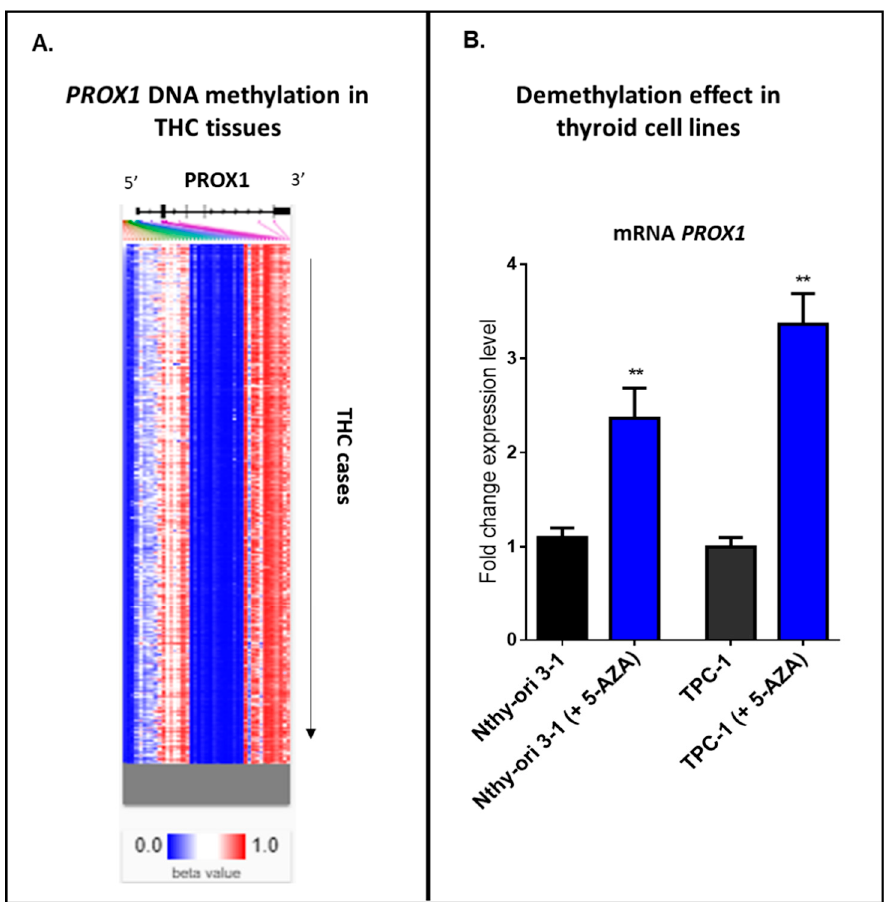
Figure 4. Methylation in THC cases. A. Hierarchical clustering of THC tissues; blue indicates a low level or no methylation for PROX1; red indicates a high methylation level. The methylation analysis was studied using https://xenabrowser.net/heatmap/. B. Treatment of the immortalized normal thyroid cells (Nthy ori-3-1) and PTC-derived cell line (TPC-1) with 5 μ M 5-aza-2’-deoxycytidine for 24 h, ** p ≤ 0.01.